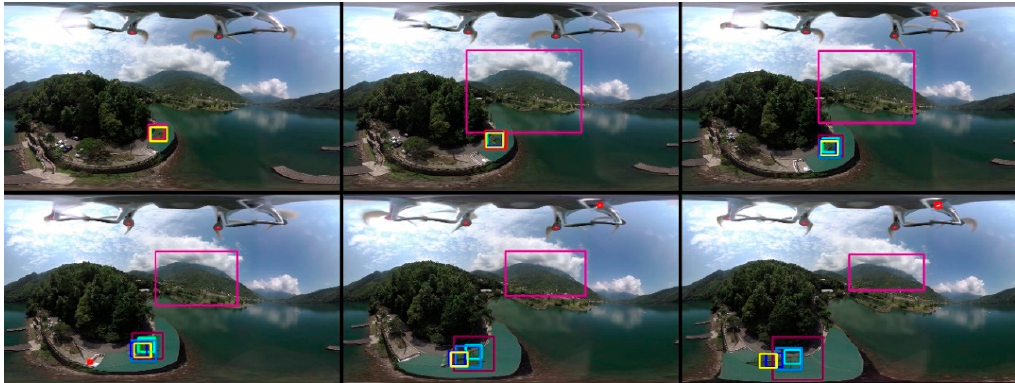
Figure 6. Tracking results on 360-degree video sequence 3 (tracking windows with different colors: MOSSE MIL MedianFlow BOOST TLD KCF GOTURN CSRT).